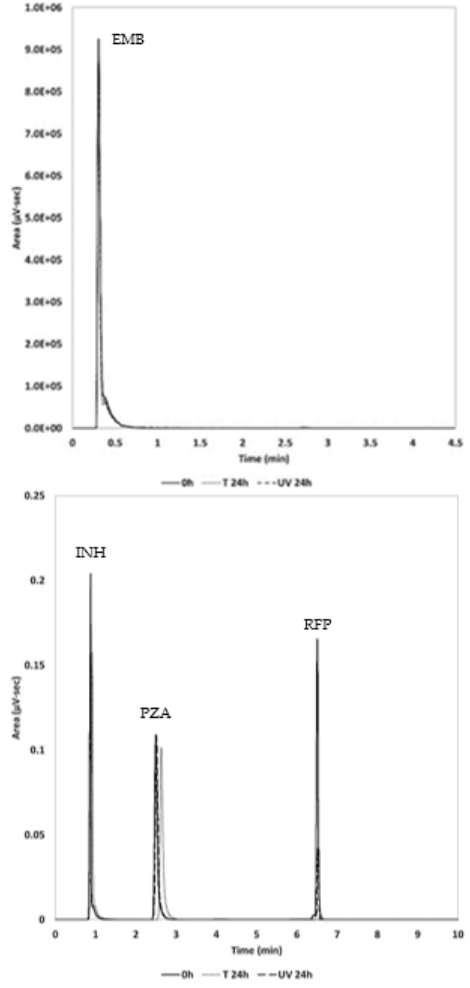
Figure 2. Chromatogram obtained from the analysis of a standard solution with 2.8 µ g/mL of EMB and 10 µ g/mL of INH, PZA, and RFP.